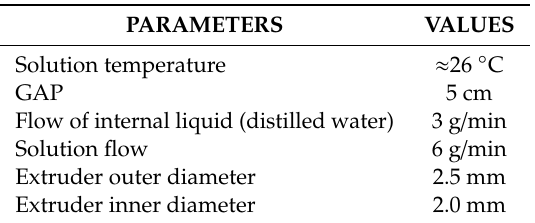
Table 1. Wiring parameters for obtaining the hollow fiber.